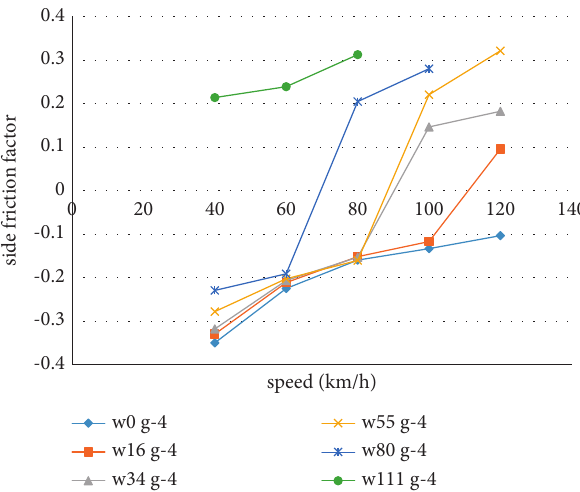
Figure 8: Comparison of maximum values of coefficient of